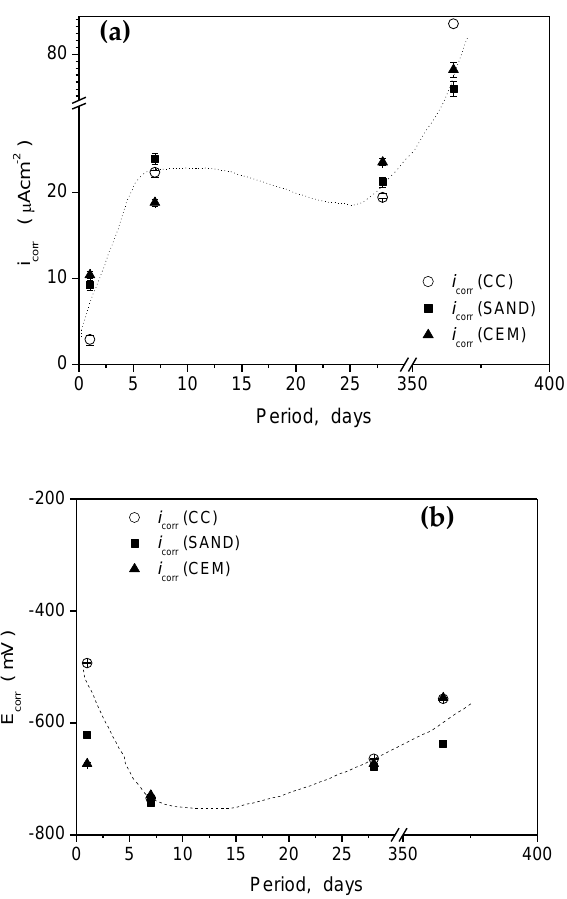
Figure 12. Variation of experimental values of: ( a ) i corr and ( b ) E corr with immersion periods of the three examined samples in NaCl solution. Associated with the observed i corr trend during the immersion period, the E corr with immersion period similarly varies for all samples examined. At initial immersion, the E corr